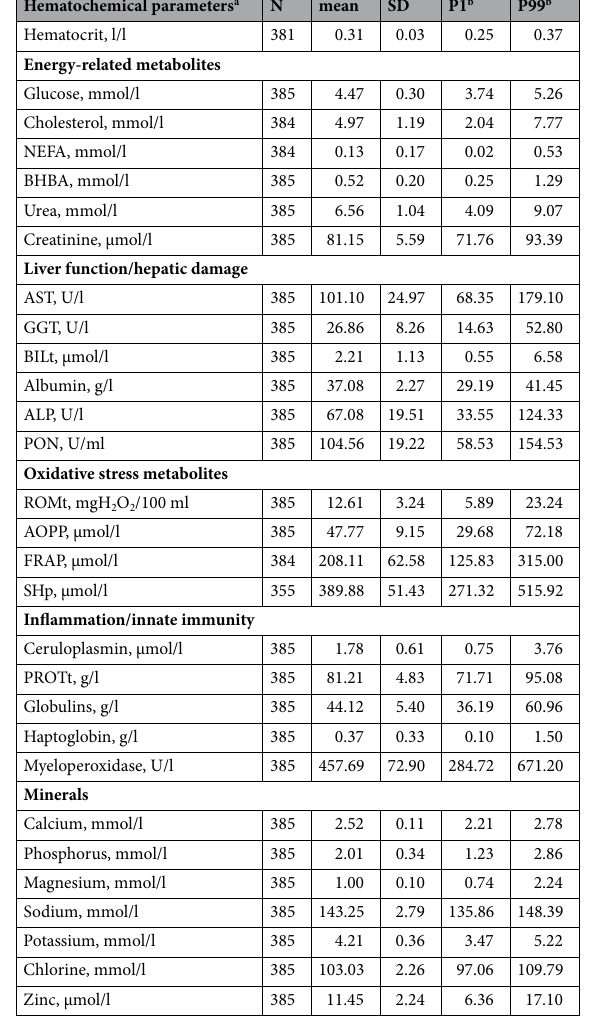
Table 1. Descriptive statistics for hematochemical parameters in all cows involved in the study. a NEFA non-esterified fatty acids, BHBA β-hydroxybutyric acid, AST aspartate aminotransferase, GGT γ-glutamyl transferase, BILt total bilirubin, ALP alkaline phosphatase, PON paraoxonase, ROMt total reactive oxygen metabolites, AOPP advanced oxidation protein products, FRAP ferric reducing antioxidant power, SHp thiolic groups, PROTt total proteins. b P1 and P99 represents 1 and 99% of the trait quantile in